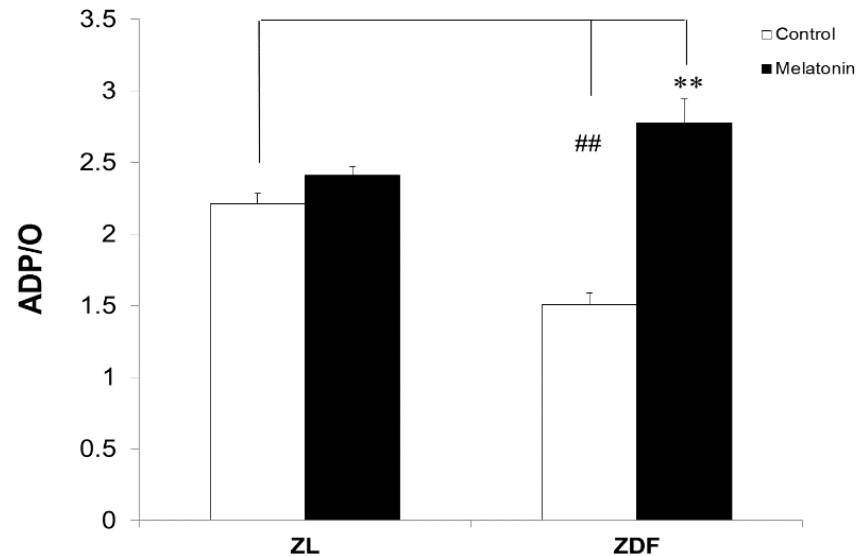
Figure 3. Respiratory phosphorylation coefficient (ADP/O ratio) of brown adipose tissue (BAT)- isolated mitochondria from control (untreated) and melatonin-treated ZDF and ZL rats. Values are shown as mean ± SD. Superscript characters show significant differences determined by two- way ANOVA followed by the Tukey post hoc test ( ** p < 0.01, M-ZDF compared with C-ZDF rats; ## p < 0.01, C-ZDF and M-ZDF compared with C-ZL rats).